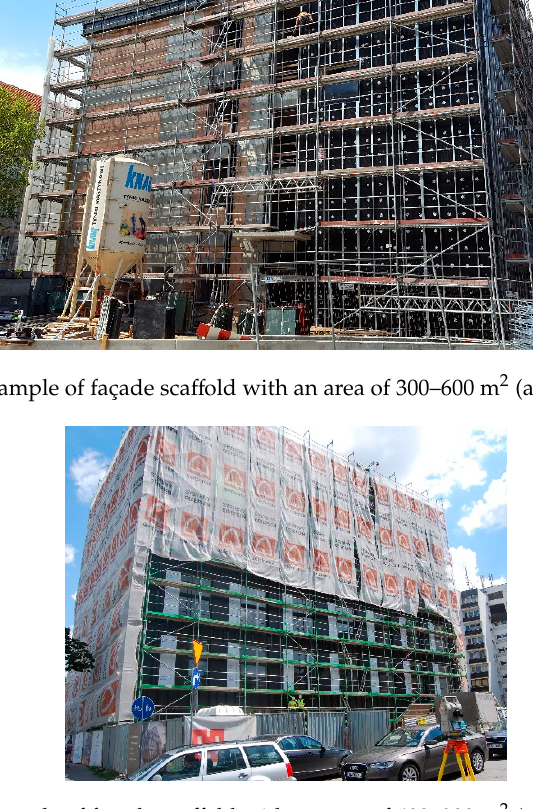
Figure 8. Example of façade scaffold with an area of 600-900 m 2 (authors’ archive).